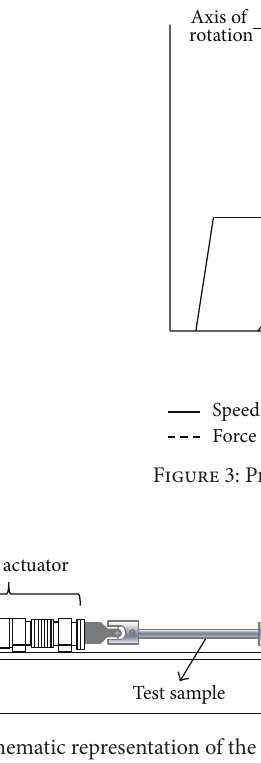
major welding parameters during the process is graphically demonstrated in Figure 3.